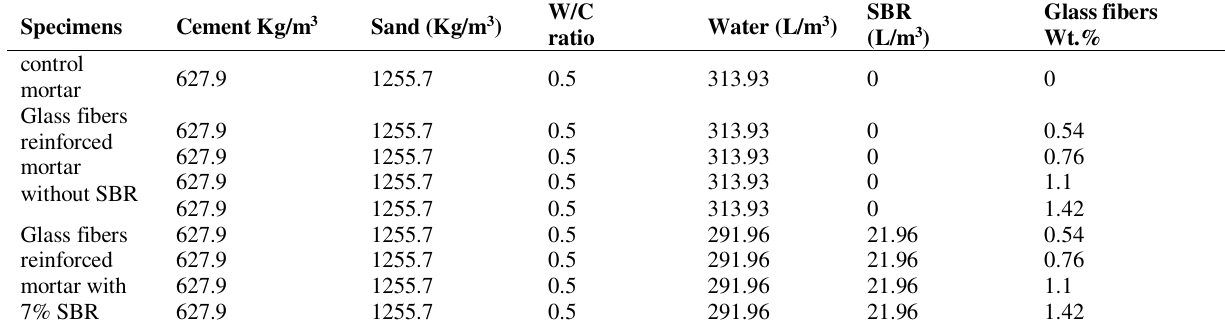
Mix design proportions.